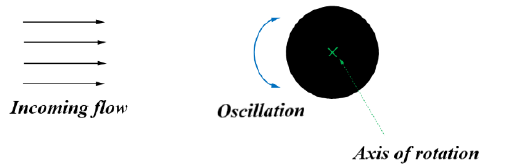
Figure 7. The schematic diagram of the rotational oscillation cylinder.